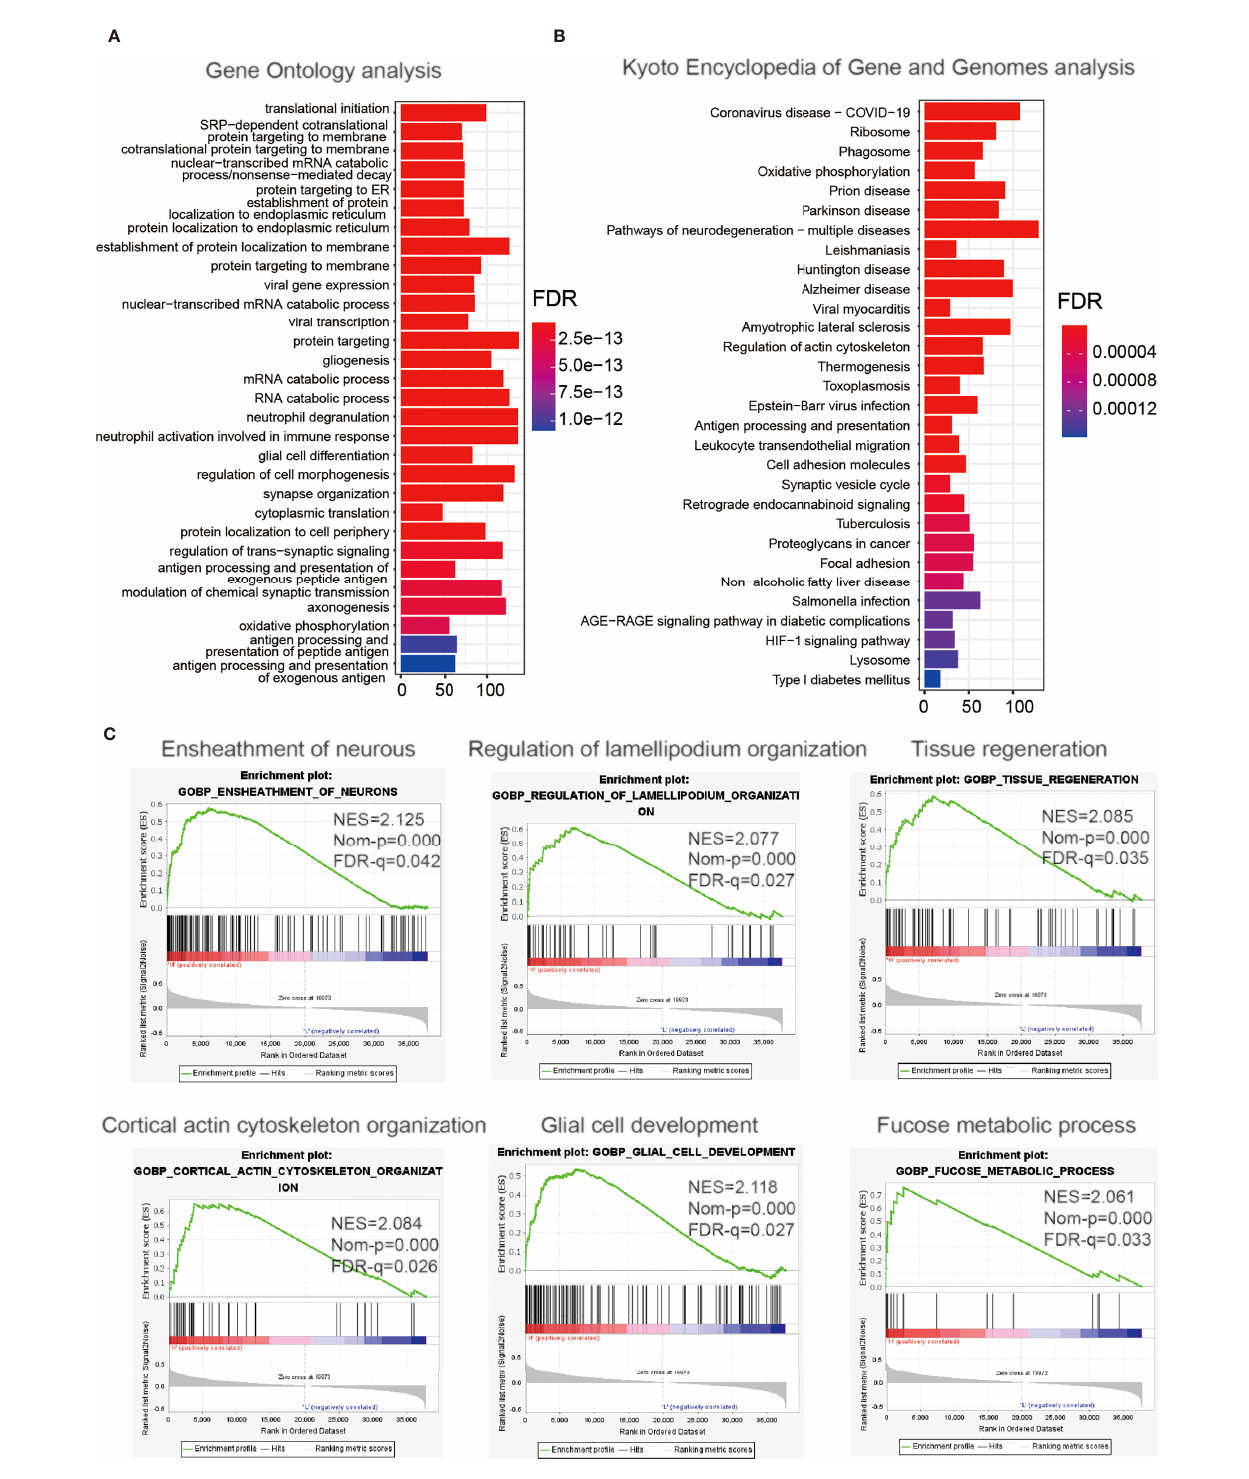
FIGURE 4 | Enrichment analysis of integrin alpha-2-related genes. Functional analysis of 2,486 differentially expressed genes between the low- and high-expression groups. (A) Gene Ontology analysis of biological processes. (B) Kyoto Encyclopedia of Genes and Genomes pathway analysis. (C) Gene Set Enrichment